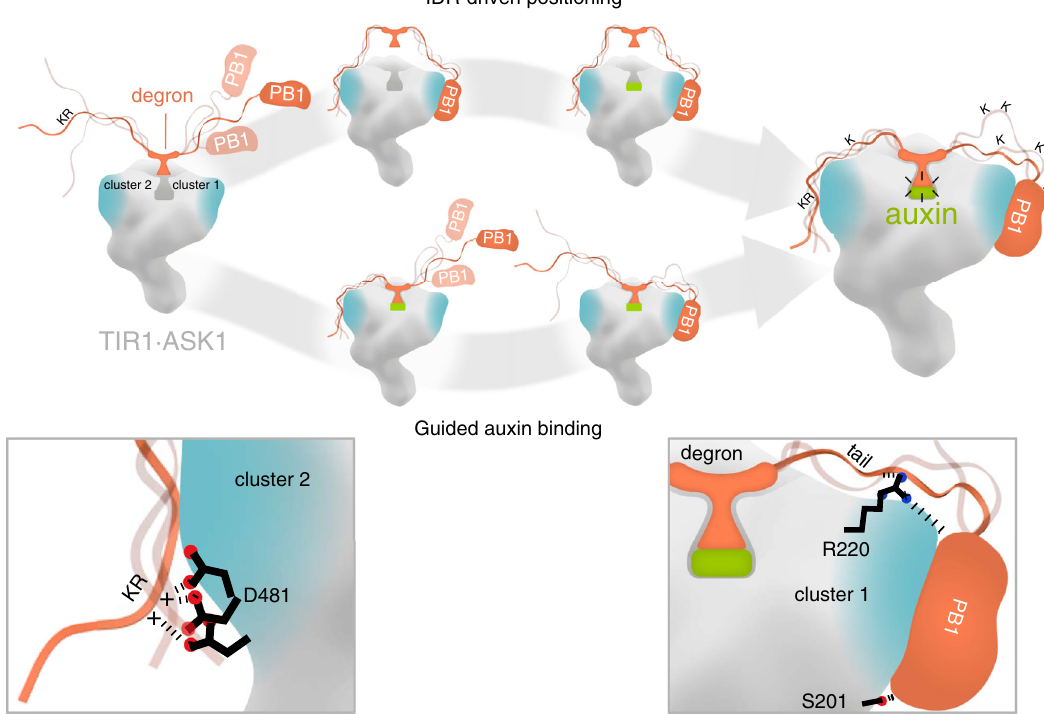
Fig. 8 Model for ASK1·TIR1·AUX/IAA complex assembly fi ne-tuned by IDRs fl anking the AUX/IAA degron. The F-box protein TIR1 of the SCF TIR1 E3 ubiquitin ligase recruits AUX/IAA targets for their ubiquitylation and degradation. The phytohormone auxin and a core degron in AUX/IAAs are essential for AUX/IAA recognition. Intrinsically disordered regions (IDRs) fl anking the degron provide high fl exibility and an extended fold to AUX/IAAs, in fl uencing TIR1·AUX/IAA complex formation. At least two different routes are possible for dynamic AUX/IAA recruitment and UPS-mediated degradation: (i) auxin- triggered association between TIR1 and the AUX/IAA degron paves the way for positioning adjacent IDRs, which exposes ubiquitin acceptor sites for ef fi cient ubiquitylation; (ii) transient auxin-independent interactions between IDRs, as well as the PB1 domain in AUX/IAAs, and two patches (clusters 1 and 2) of residues at opposite sides of TIR1, assist on auxin binding and offer tailored positioning. Residues R220 and S201 from cluster 1 (right zoom in) and D481 from cluster 2 (left zoom in) in TIR1 play a major role in TIR1·AUX/IAA complex formation. The residency time of an AUX/IAA target on TIR1, enables processivity of AUX/IAA ubiquitylation, and impinges on availability of IDRs as initiation sites for degradation by the 26S